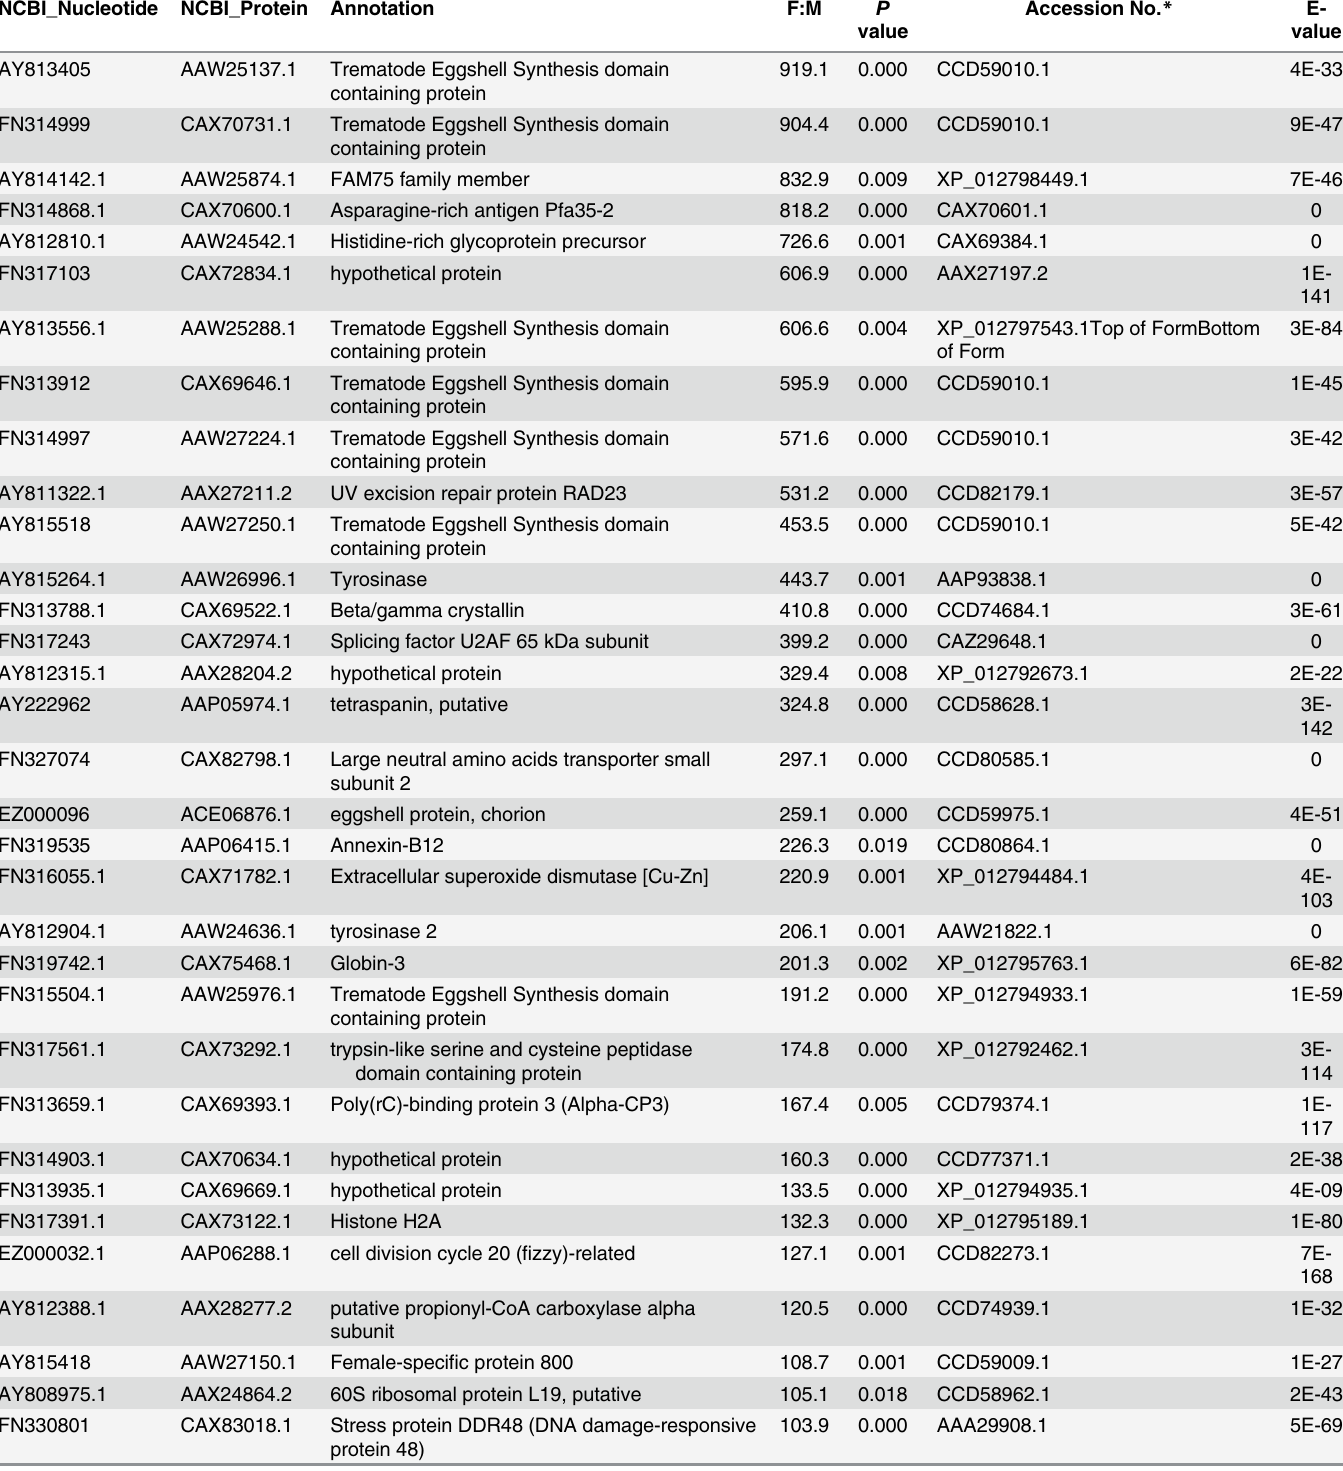
Table 3. Top 40 adult female-biased expressed genes in S . japonicum